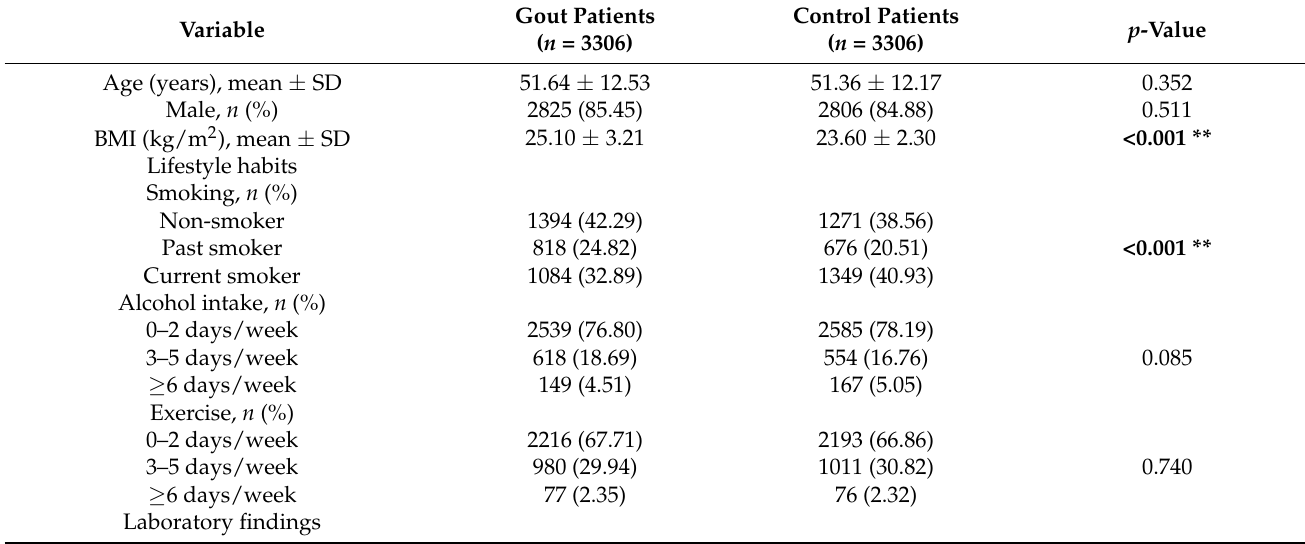
Table 1. Baseline characteristics and outcome events of gout and control